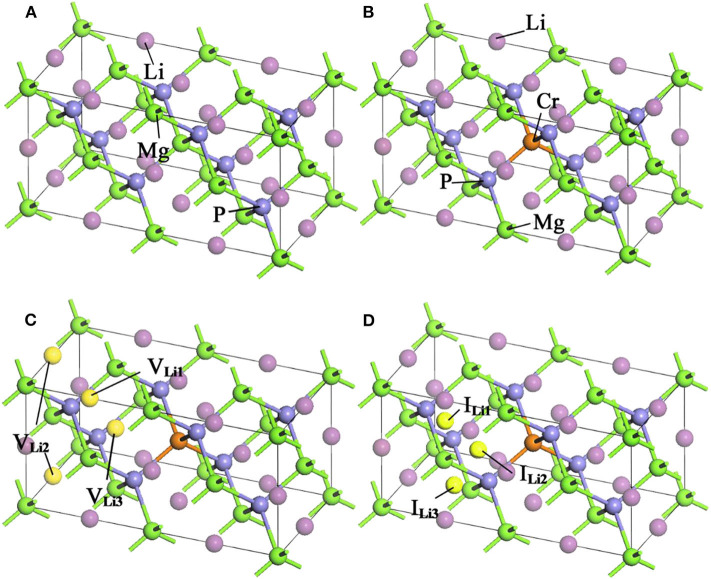
Supercell structures of Li1±y(Mg1−xCrx)P: (A) LiMgP, (B) Li(Mg0.875Cr0.125)P, (C) Li0.875(Mg0.875Cr0.125)P, and (D) Li1.125(Mg0.875Cr0.125)P.